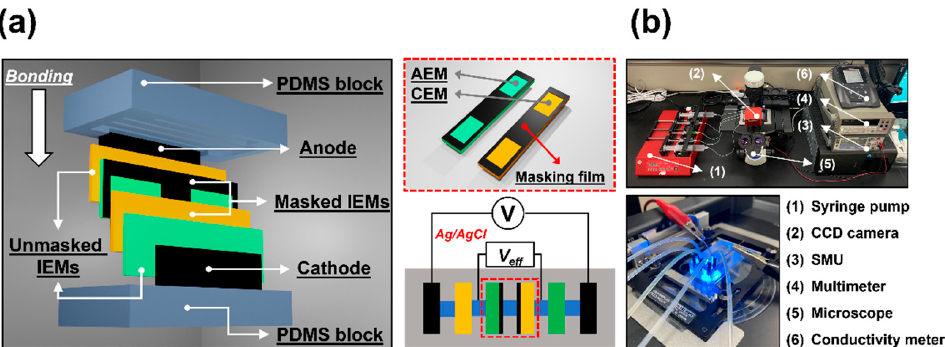
Figure 2. ( a ) Schematics of PDMS-based microscale electrodialysis fabrication and the masked ion- exchange membranes. Masking film of 30 µm thickness was deposited onto the ion-exchange membranes (a pair of AEM/CEM) to physically block the nanopores. The masked membranes were embedded in the second channel (the main channel) from the top; the unmasked membranes were embedded in the first and third channels. The Ag/AgCl electrode was inserted between the first and second channels to measure the electrical responses in the main channel (red dotted box at bottom).